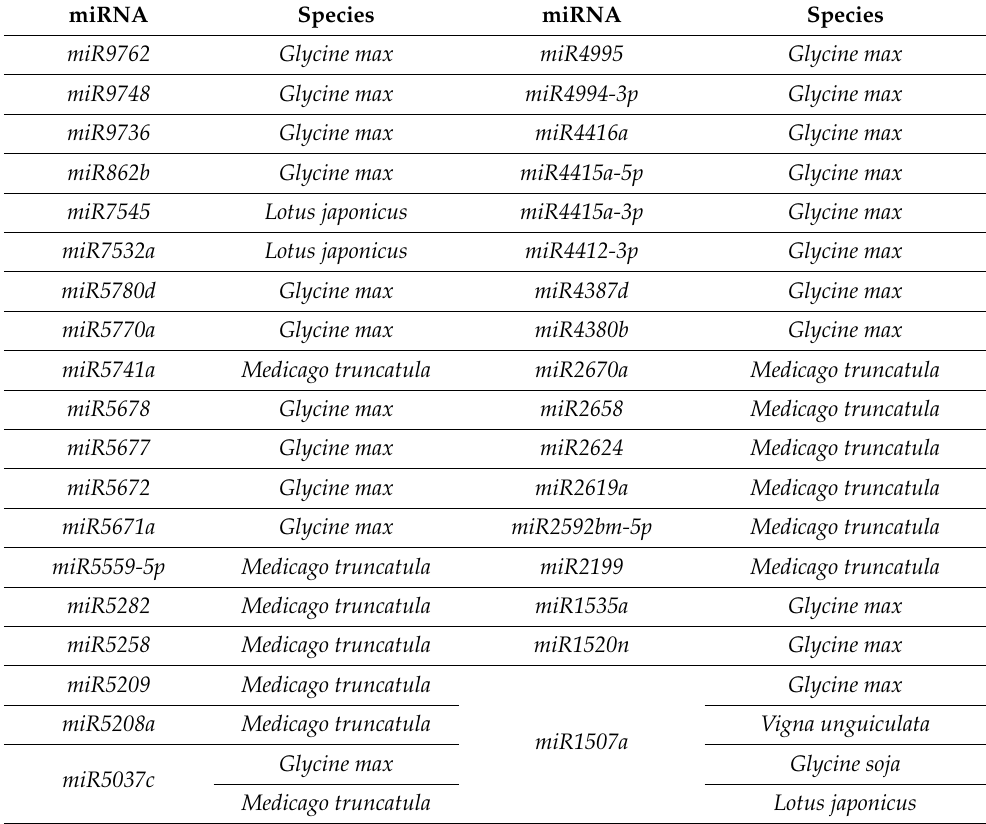
Table 3. Known miRNAs that were specifically conserved in legumes from Gleditsia sinensis